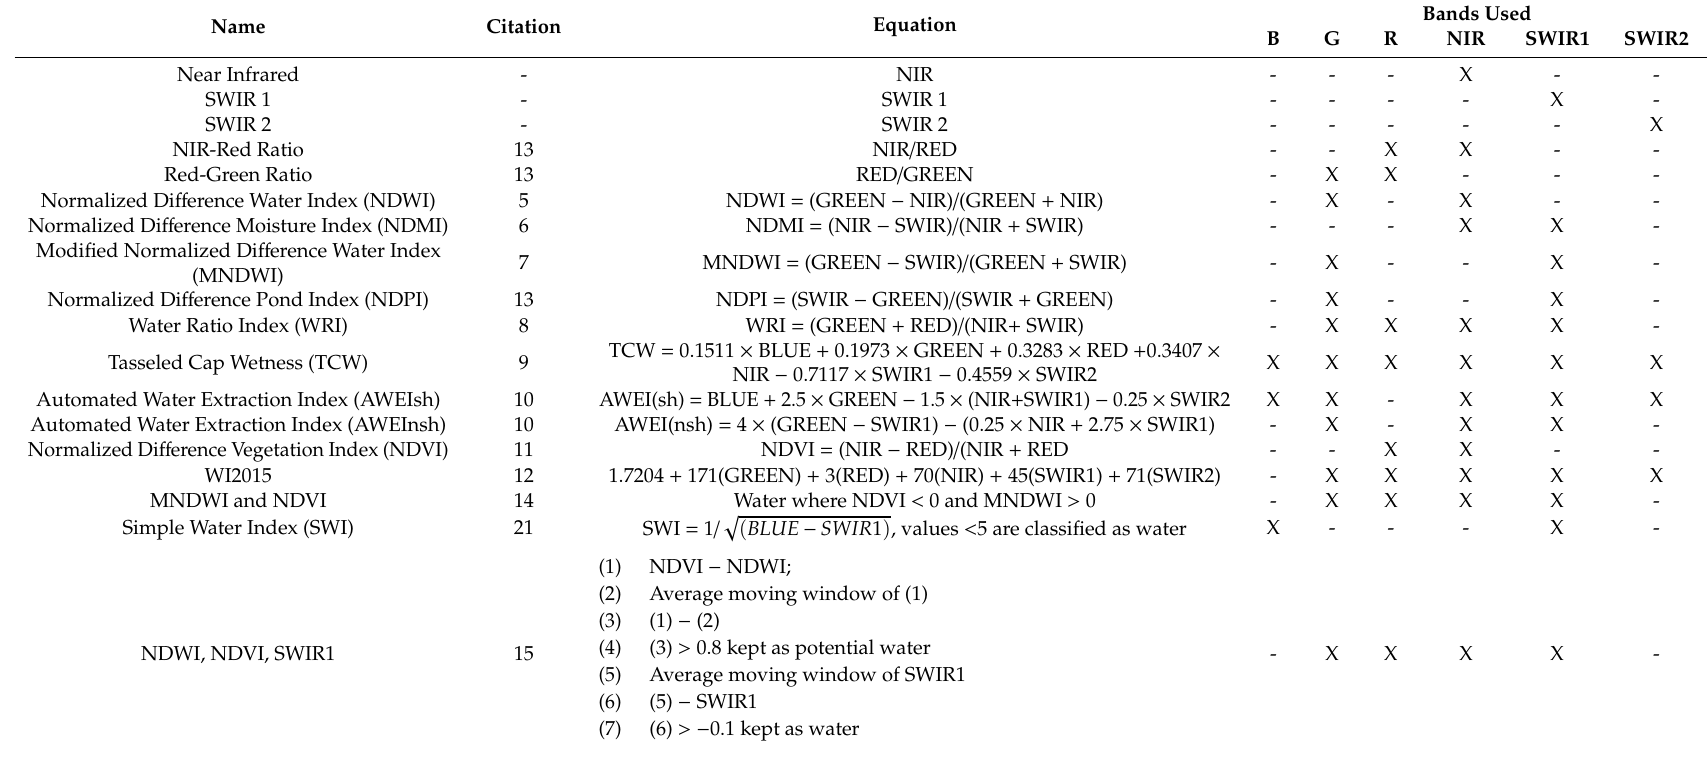
Table 3. Methods of surface water